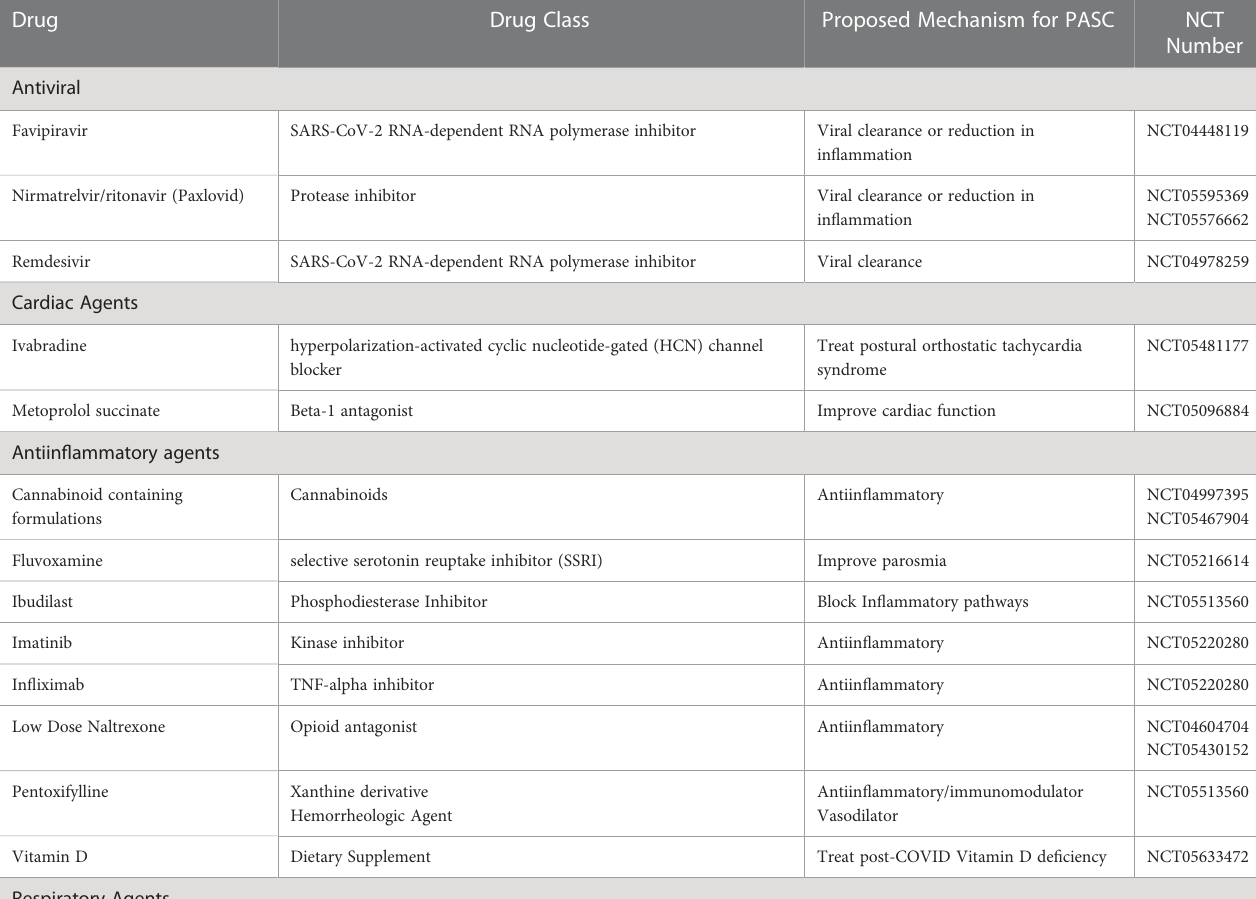
TABLE 1 Selected pharmaceutical interventions currently listed in ClinicalTrials.gov * .